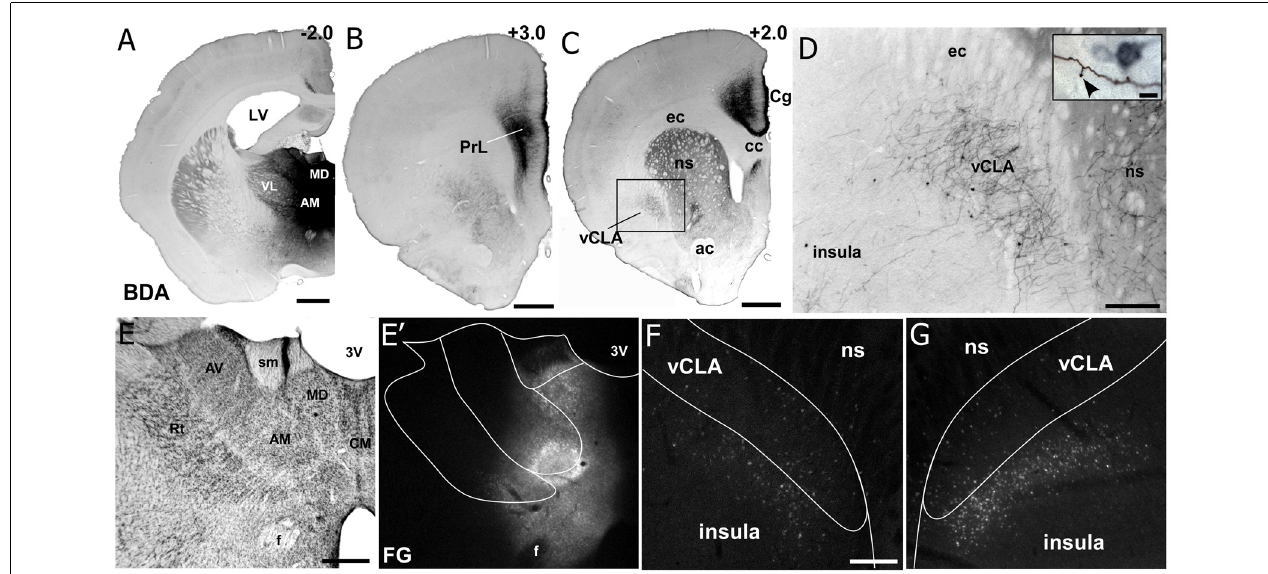
FIGURE 6 | Neuroanatomical tracing from MD thalamus clarifies the connectivity with insular cortex and claustrum. (A) Image showing a bi-directional anterograde/retrograde BDA/FG injection into MD thalamus, specifically showing the DAB visualization of the BDA. (B) Strong connections are observed with layer 1 as well as layers 5 and 6 of PrL cortex. (C) MD thalamus also showed strong connections to Cg cortex, ventral striatum (VS), and CLA. (D) Higher magnification of labeling in CLA after MD injection shows mostly terminal labeling, with few retrogradely labeled neurons. Closer inspection of terminals in the inset show a classic “drum-stick” morphology, possibly indicating a “modulator-like” synapse. (E–G) Images of the FG labeling from an adjacent section from the injection shown in (A) . Not that almost all of the feedback to thalamus originates from insula and not the CLA. Numbers in upper right corner of panels indicate distance from Bregma in millimeter. Scale bars: 1 mm in (A–C) ; 250 µ m in (D) and 10 µ m in inset. Data modified with permission from Smith et al. (2017). Abbreviations: 3V, third ventricle; LV, lateral ventricle; AM, anteromedial thalamic nucleus; AV, anteroventral thalamic nucleus; VL, ventral lateral nucleus; MD, mediodorsal nucleus; ac, anterior commissure; CM, centromedial thalamic nucleus; cc, corpus callosum; ec, external capsule; ns, neostriatum; Rt, thalamic reticular nucleus; sm, stria medularis; f, fornix; vCLA, ventral claustrum.